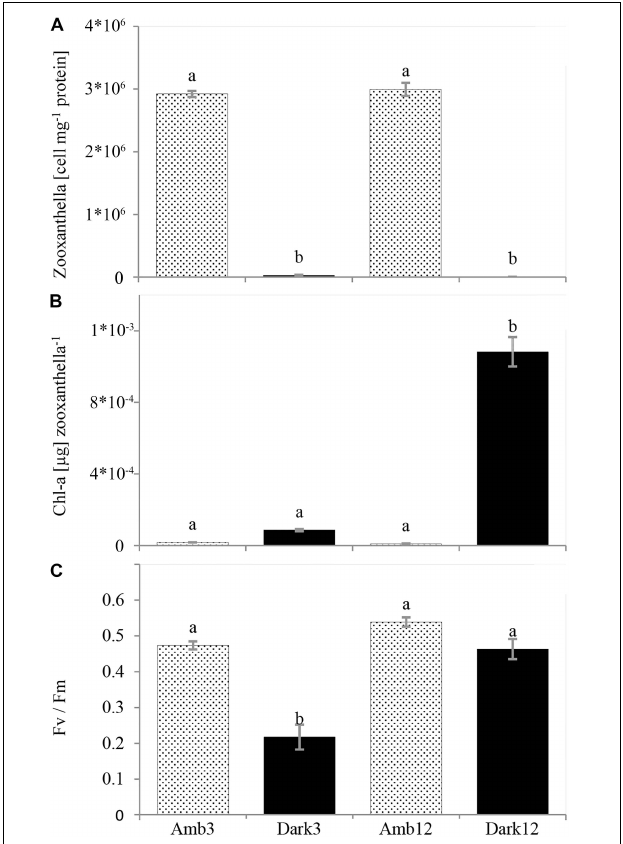
FIGURE 3 | O. patagonica mean photosynthetic parameters ( ± SE, N = 3, per timepoint). Zooxanthellae count per host protein (A) , chlorophyll- a concentration per zooxanthella (B) , and Fv/Fm (C) . Different lowercase letters indicate significantly different samples (see Table 2 for exact values).